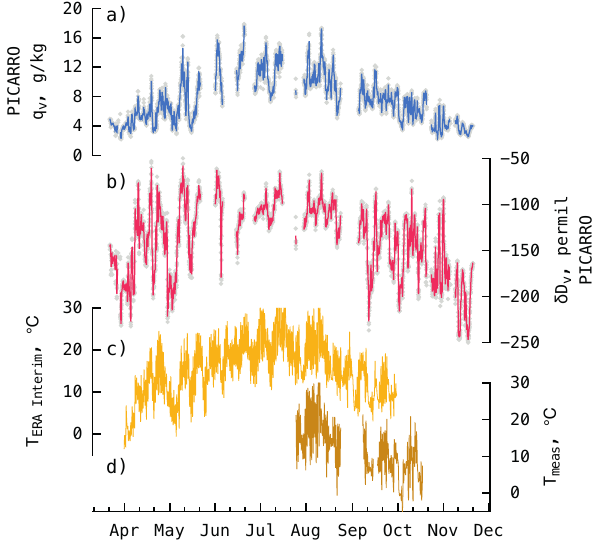
Figure 3. Time series including (a) hourly (grey dots) and run- ning (five-point, blue curve) means of specific humidity measured by PICARRO at Kourovka station, (b) hourly (grey dots) and run- ning (five-point, red curve) means of δ D measured by PICARRO at Kourovka, (c) local temperature derived from ERA-Interim reanaly- sis data, (d) local temperatures measured at Kourovka by MetPak-II meteorological